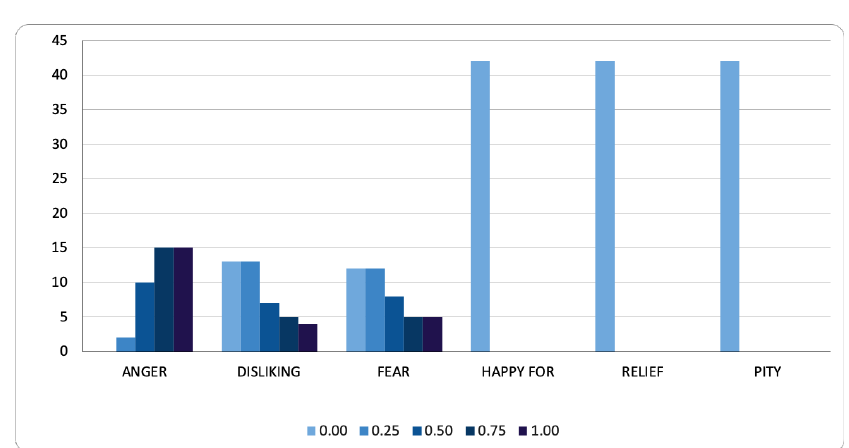
Figure 25. Result